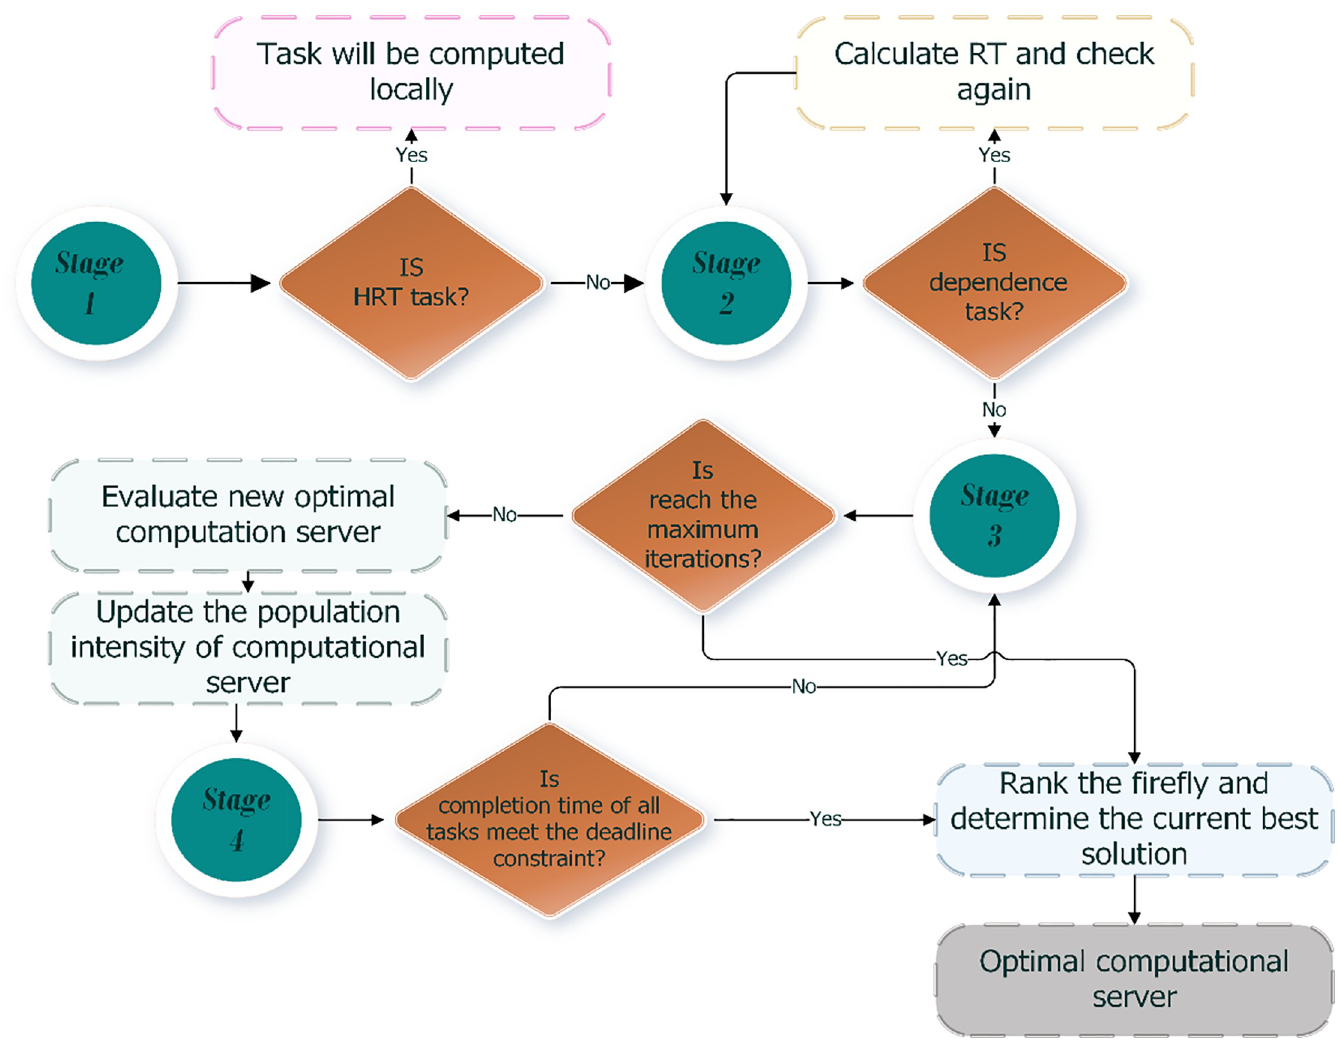
Fig 4. Flowchart of the ET-DTCO